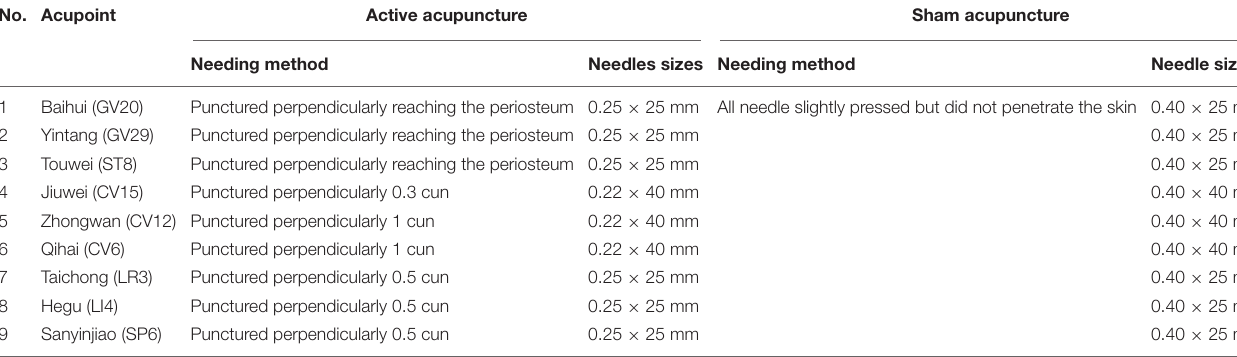
FIGURE 3 | Acupuncture acupoints and locations. TABLE 1 | Details regarding active acupuncture and sham